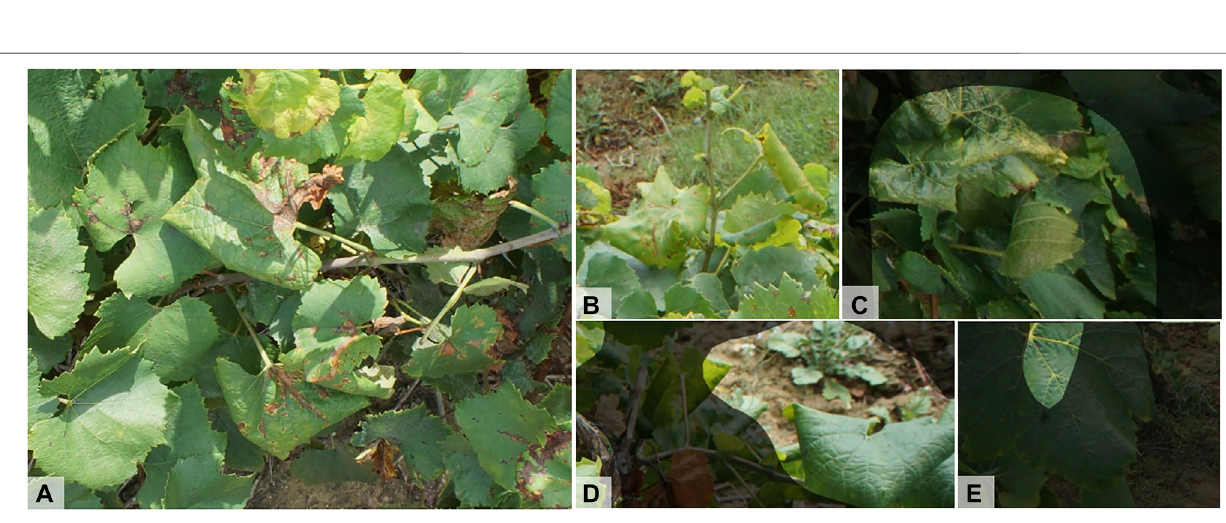
FIGURE 5 | Segmentation maps with minimum and maximum Intersection over Union (IoU) values on Chardonnay datasets. On the Pers. Chardonnay dataset, Images (A) with the lower IoU value, (B) with the higher IoU value. On the Ext. Chardonnay dataset, (C) with the lower IoU value, (D) with the higher IoU value.